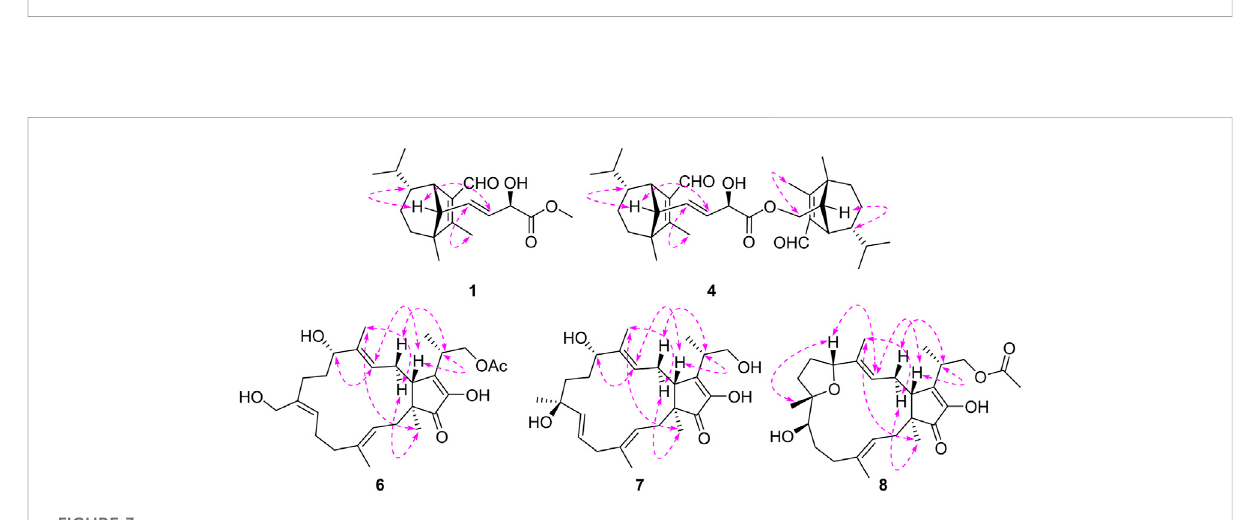
FIGURE 3 Key ROESY correlations for 1 , 4 , 6 , 7 , and 8